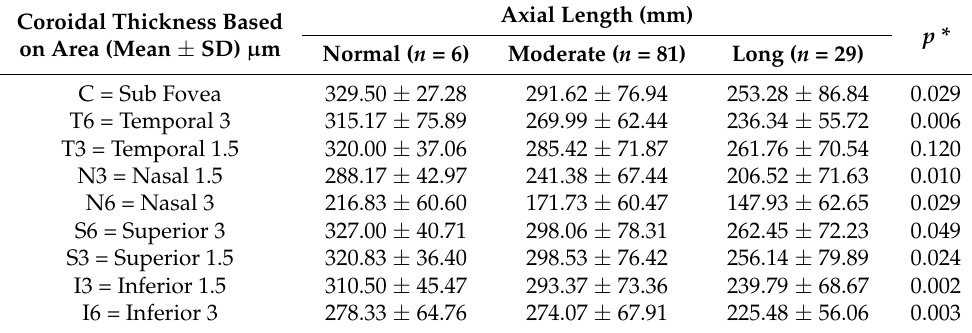
Table 2. Comparison of choroidal thickness and axial length.